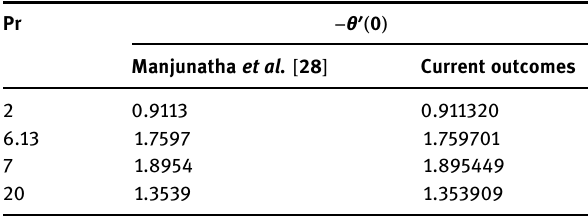
Table 2: Veri fi cation of our results with previously published results in exceptional circumstances, such as ϕ 1 = ϕ 2 = ϕ 3 = 0